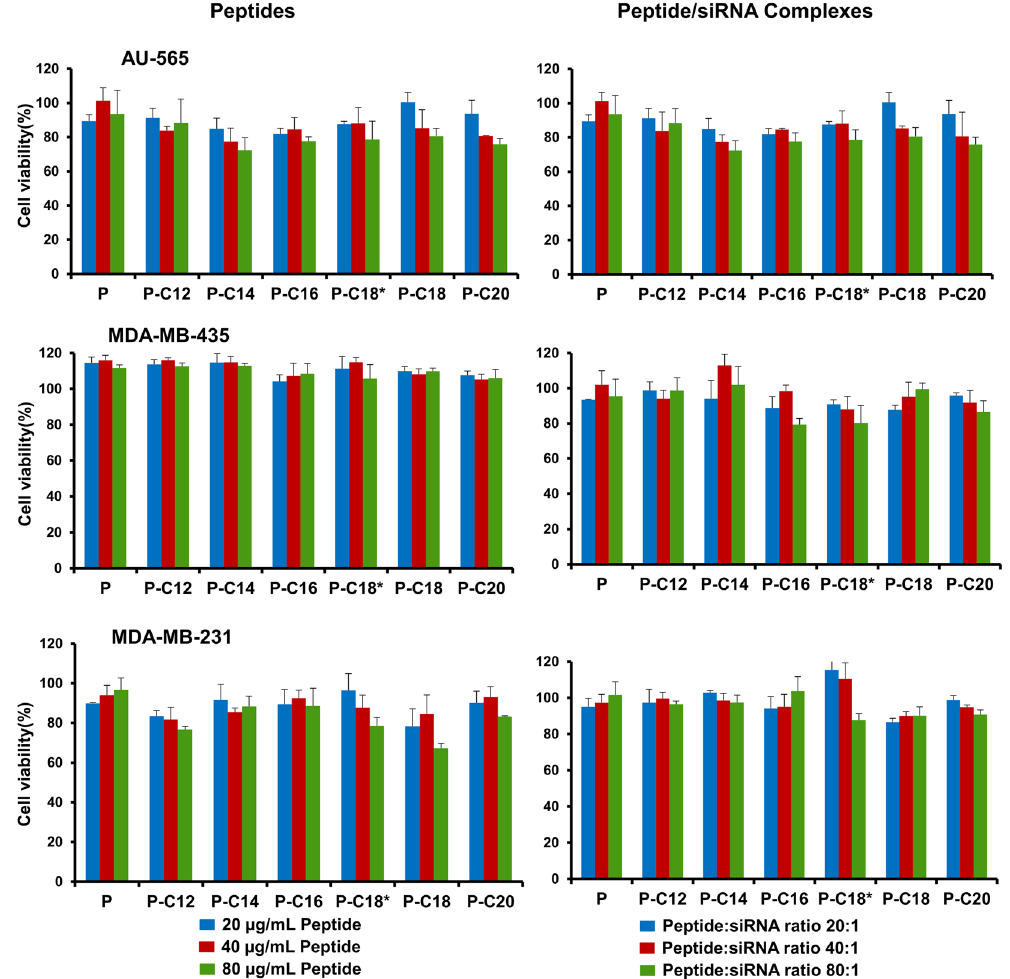
Figure 5. Cellular toxicity of peptides (left panels) and peptide/siRNA complexes (right panels). The viability of AU-565 cells, MDA-MB-435, and MDA-MB-231cells was evaluated using MTT assay after 72 h exposure to different concentration of peptides (left panels), or to complexes formed with scrambled siRNA and peptides at different peptide:siRNA w/w ratios. The percentage of viability is presented as Mean + SD; n = 3). No significant toxicity was observed for any of the studied peptides. For the similar experiment in HEK293 cells, see Supplementary Figure